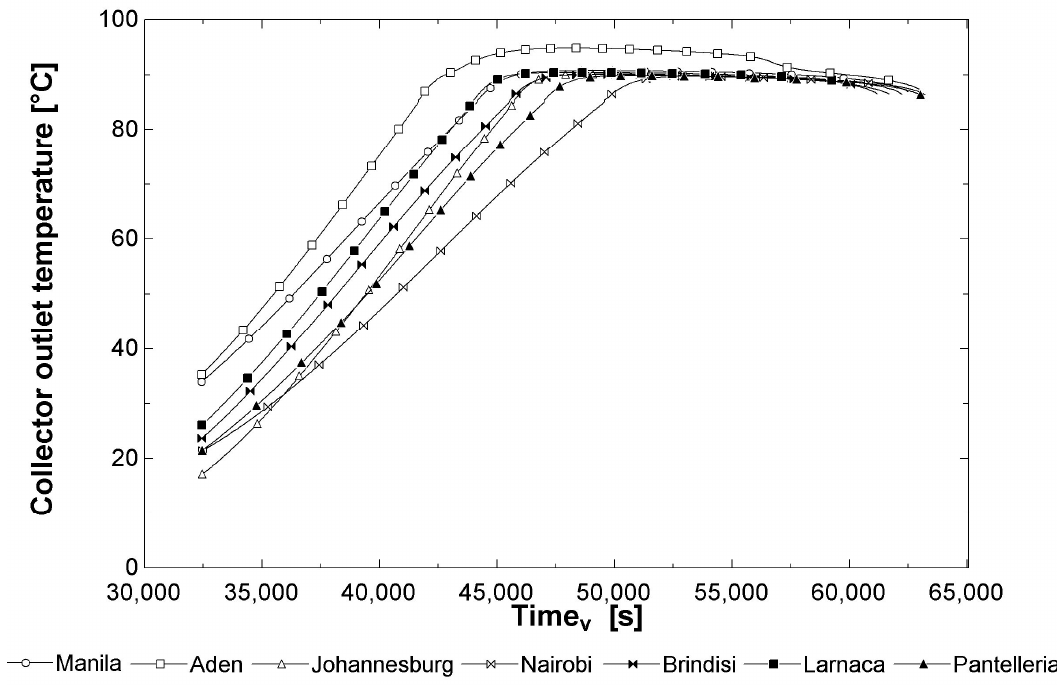
Figure 4. Collector outlet temperature in the average day of May in various location.